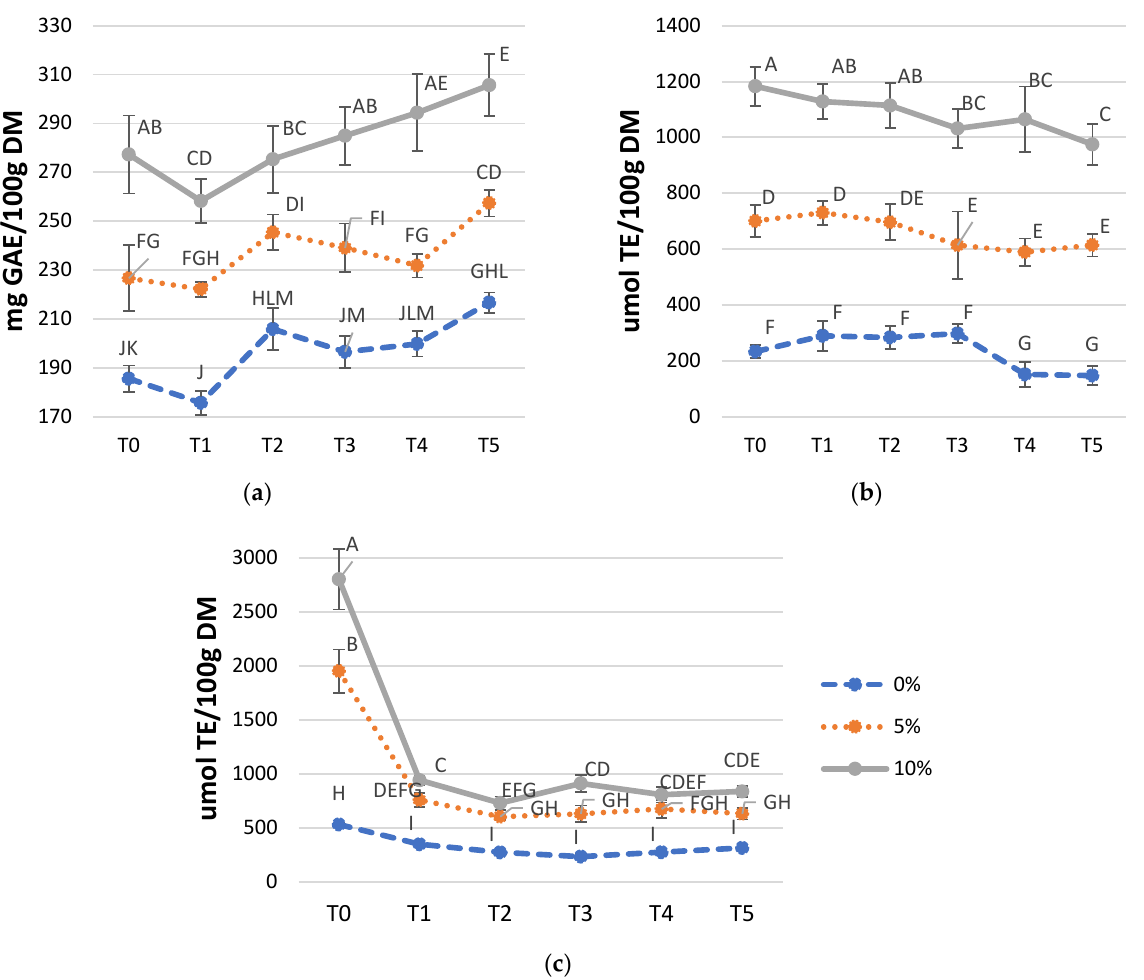
Figure 1. To different letters correspond different means within the same graph ( p < 0.05). Gray line stands for B10, orange line for B5, and blue line for B0; ( a ) TPC; ( b ) ABTS; ( c ) FRAP. GAE: gallic acid equivalent; TE: Trolox equivalent; DM: dry matter.